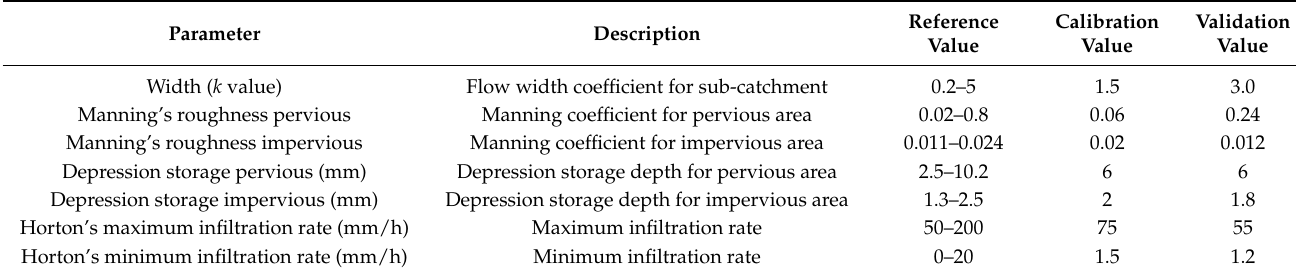
Table 6. Values selected for SWMM parameters in the THTH community.